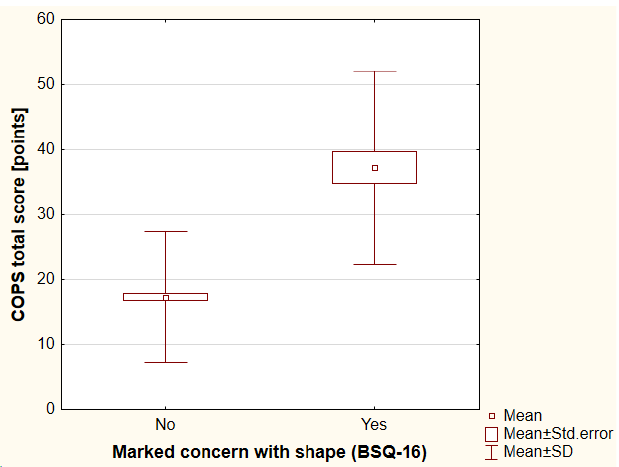
Figure 1. The differences in the COPS total score between individuals with marked concern with shape and without such concern. COPS — the Cosmetic Procedure Screening Questionnaire, BSQ-16 — the Body Shape Questionnaire-16, SD — standard deviation.